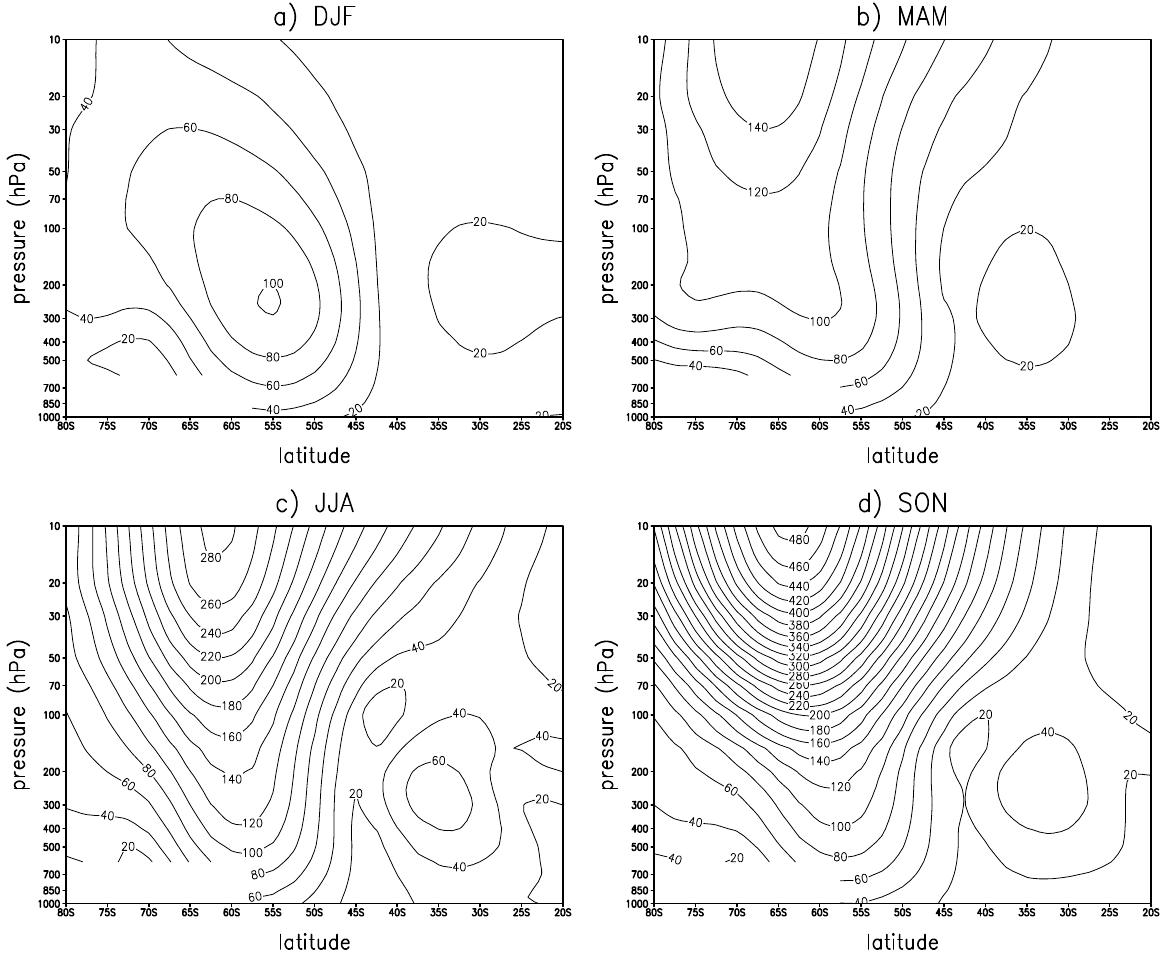
Fig. A1. Amplitudes of QS wave 1 (m) in the data set for the period 1979–1998: (a) DJF, (b) MAM, (c) JJA, and (a) d SON. Contour interval is